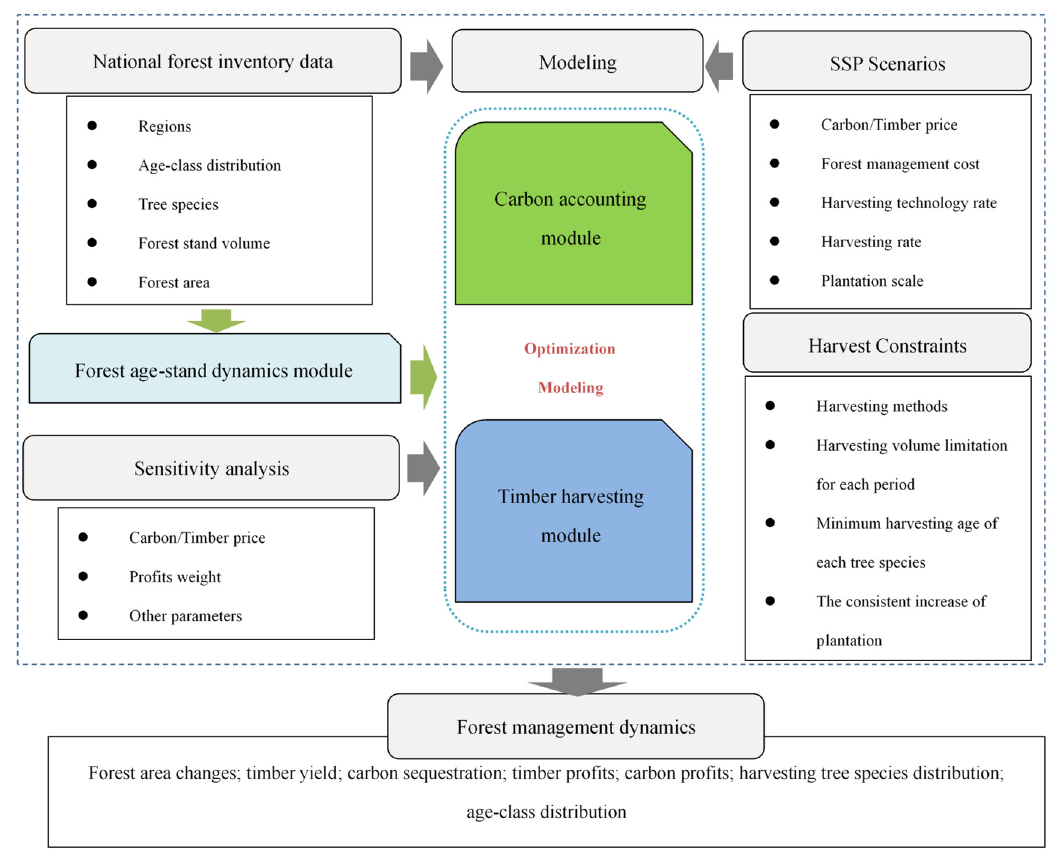
Figure 1. Research